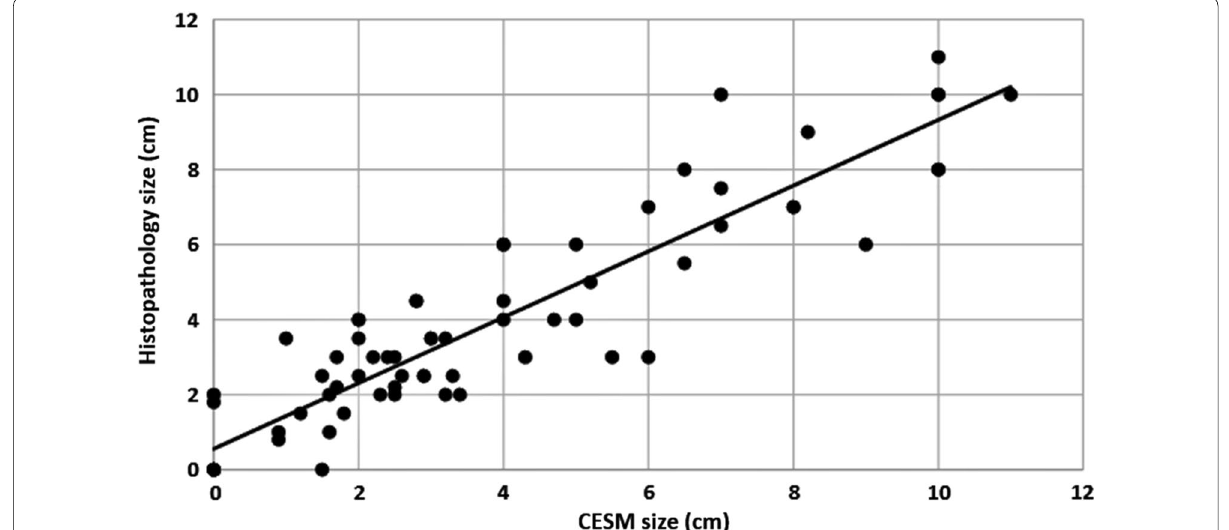
Fig. 1 Correlation between CESM size and histopathology size in our series